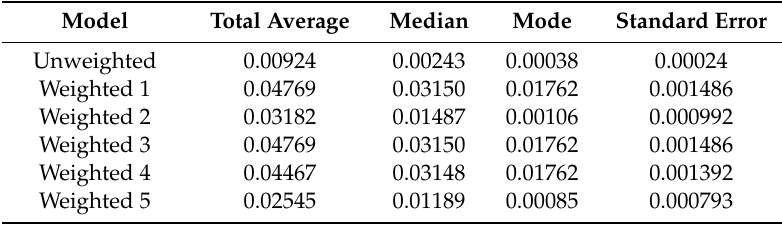
Table 5. Descriptive statistical values for raster probability values at known archaeological deposit locations (n = 1030) for each created predictive model.